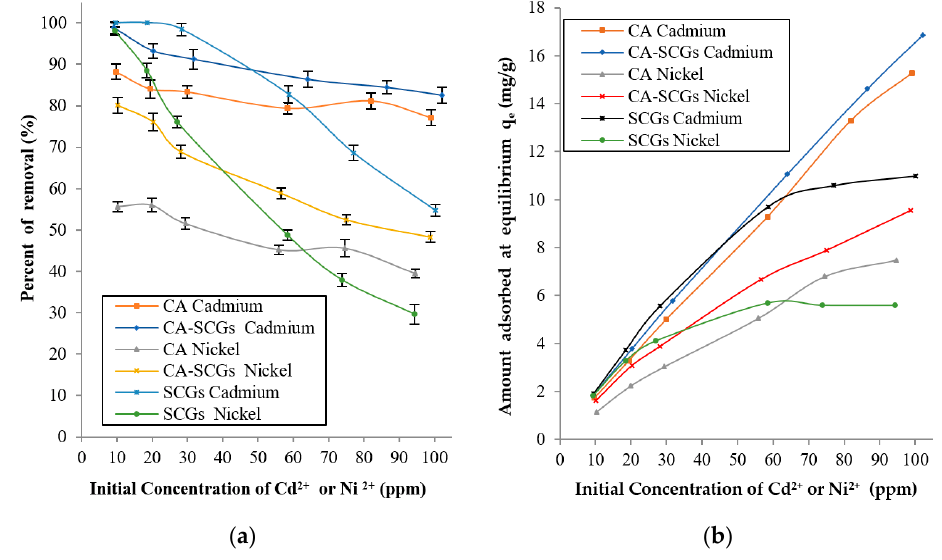
Figure 9. Amounts Cd 2+ or Ni 2+ absorbed at 24 h for each initial concentration of metal: ( a ) Percentages of removal at 24 h and ( b ) Experimental amounts of metal adsorbed at equilibrium ( q e ).